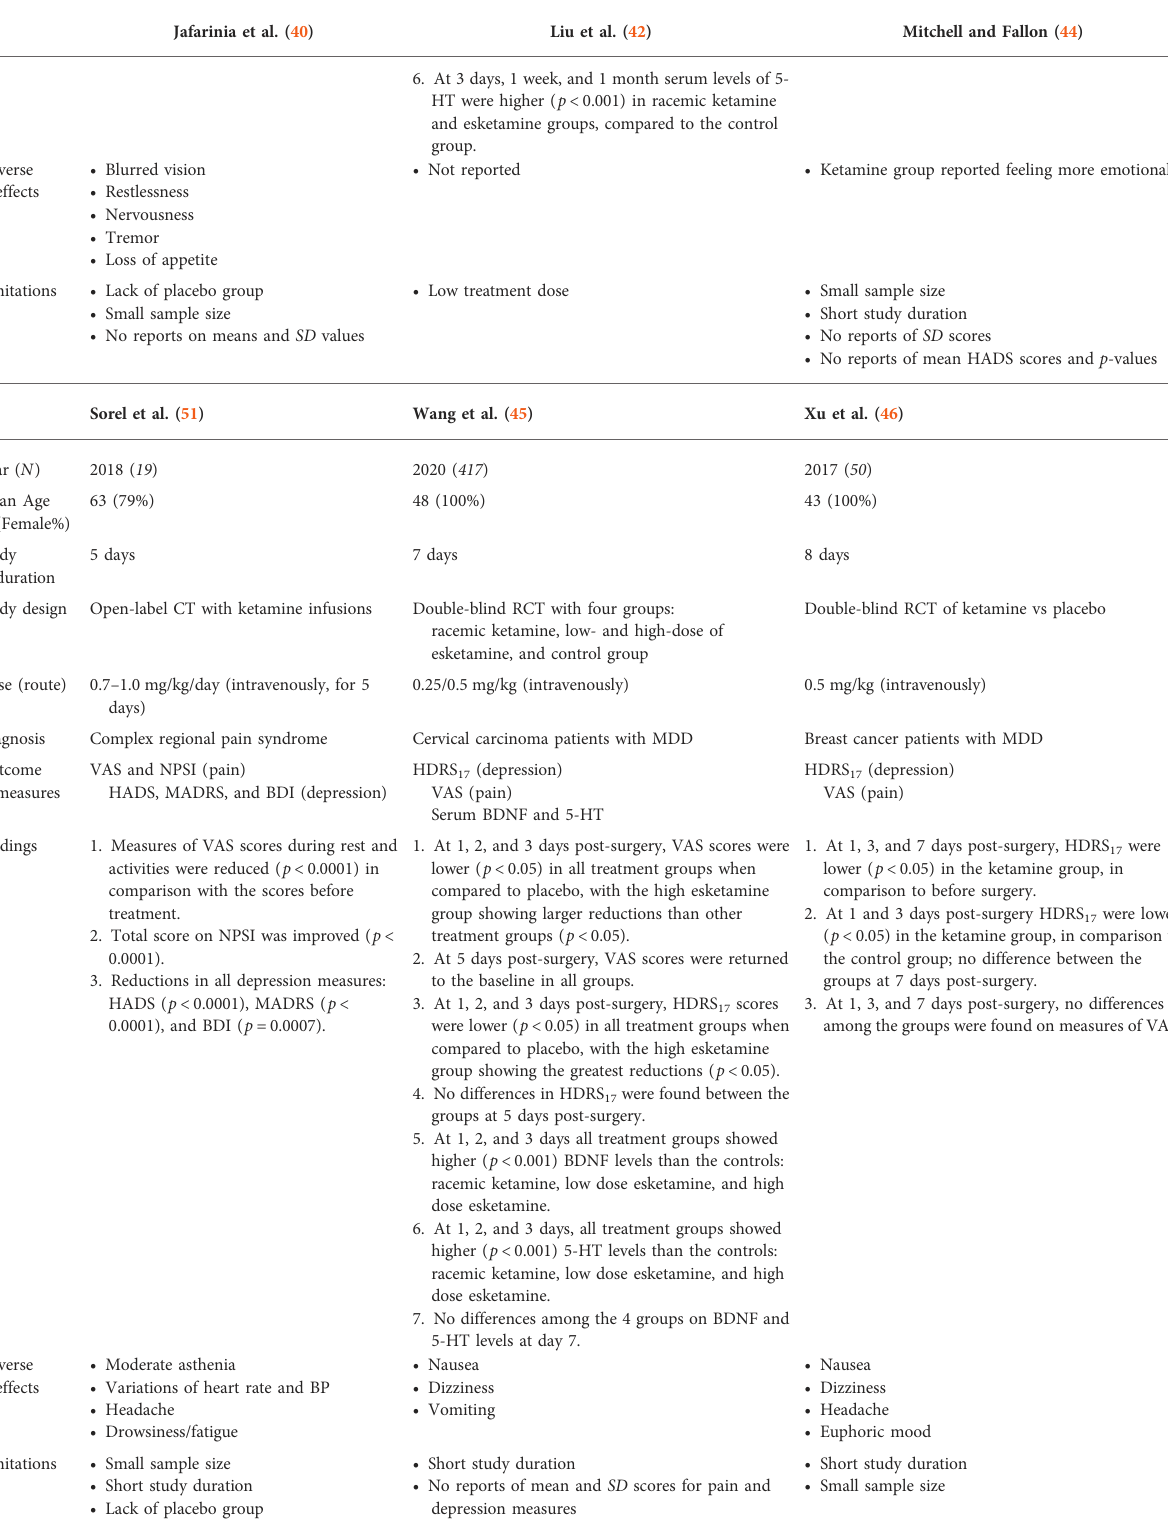
Study design Open-label CT with ketamine infusions Double-blind RCT with four groups: Dose (route) 0.7 – 1.0 mg/kg/day (intravenously, for 5 days) Diagnosis Complex regional pain syndrome Cervical carcinoma patients with MDD Breast cancer patients with MDD Outcome VAS and NPSI (pain) measures HADS, MADRS, and BDI (depression)